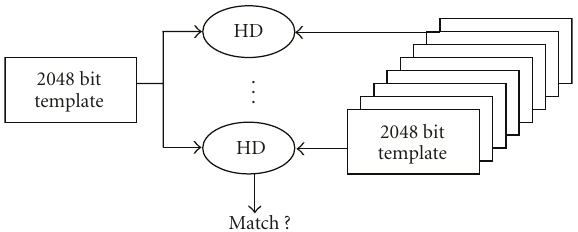
Figure 4: New template is compared with each template stored in a